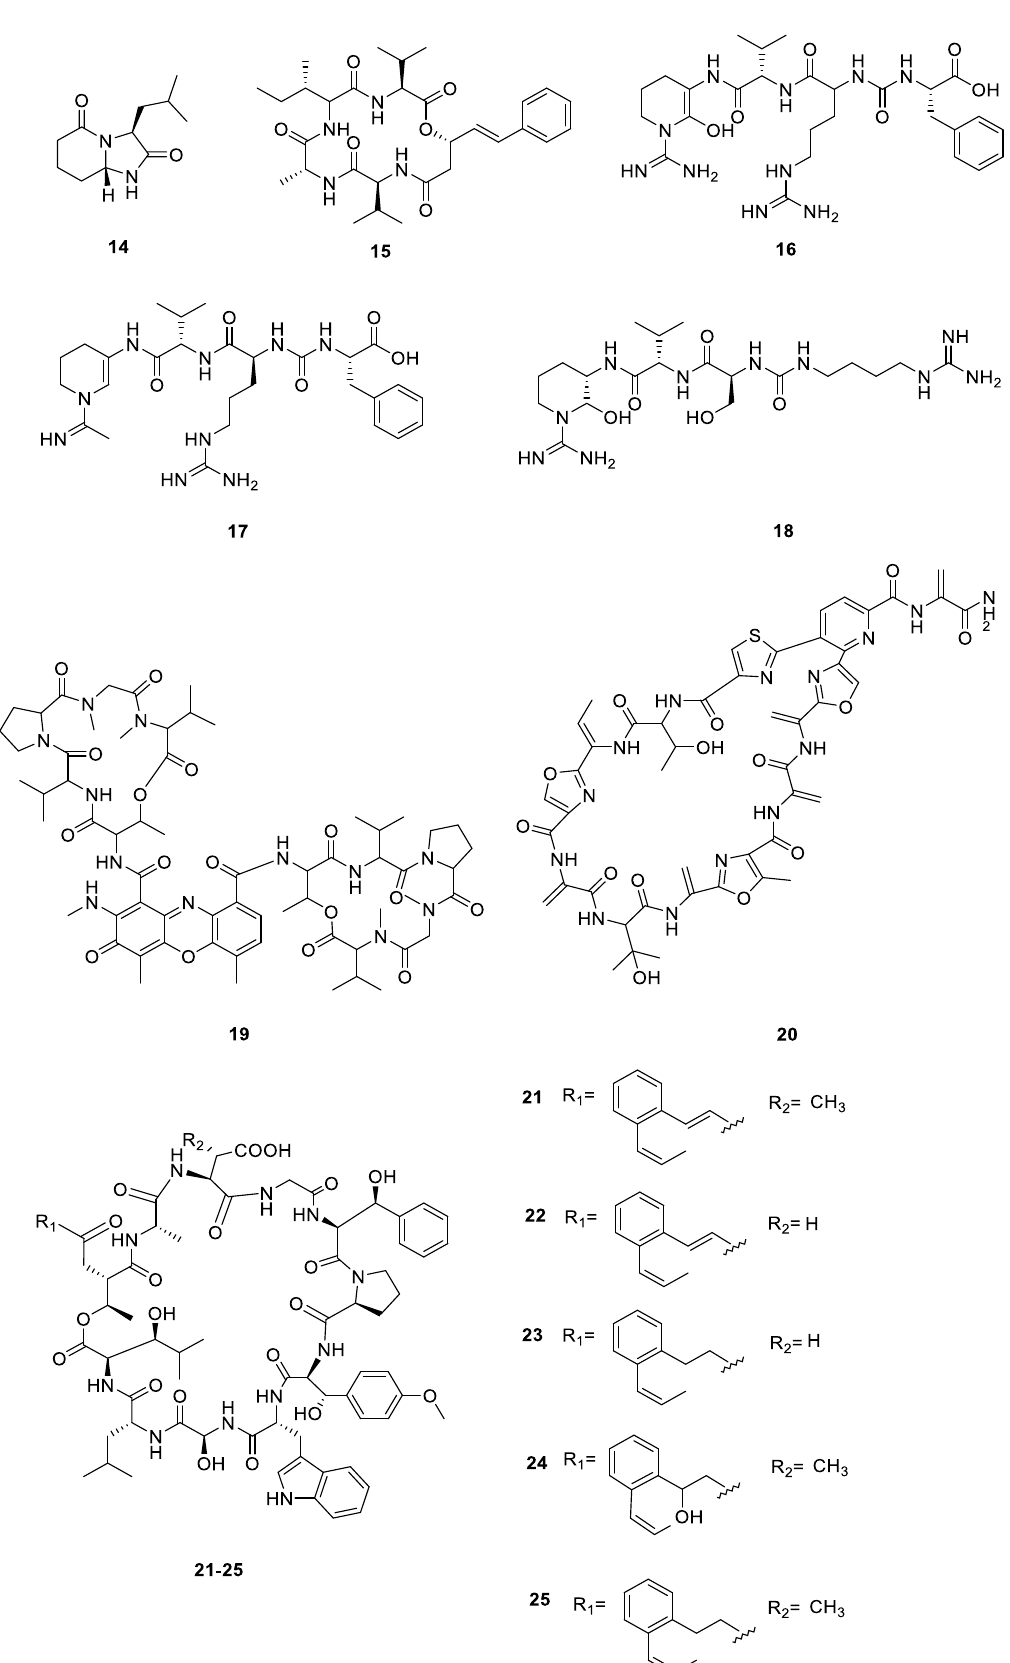
Figure 4. Chemical structures of compounds 14 − 25 from lichen-associated actinomycetota.